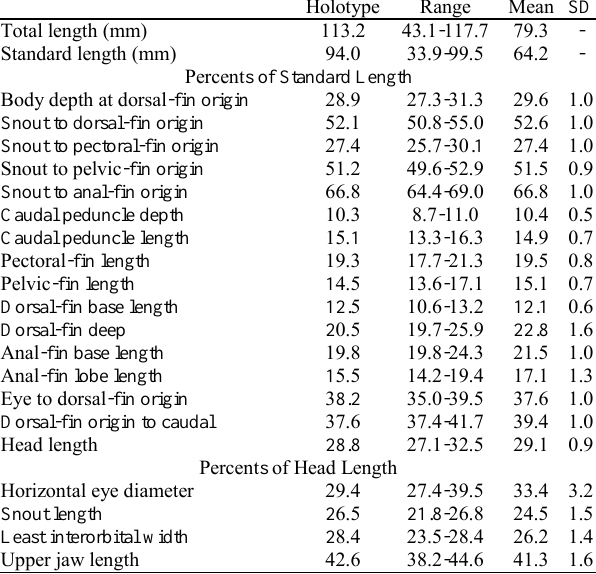
Table 2. Morphometric data of 33 specimens of Astyanax eremus from the upper rio Iguaçu. SD = Standard deviation. Range includes the